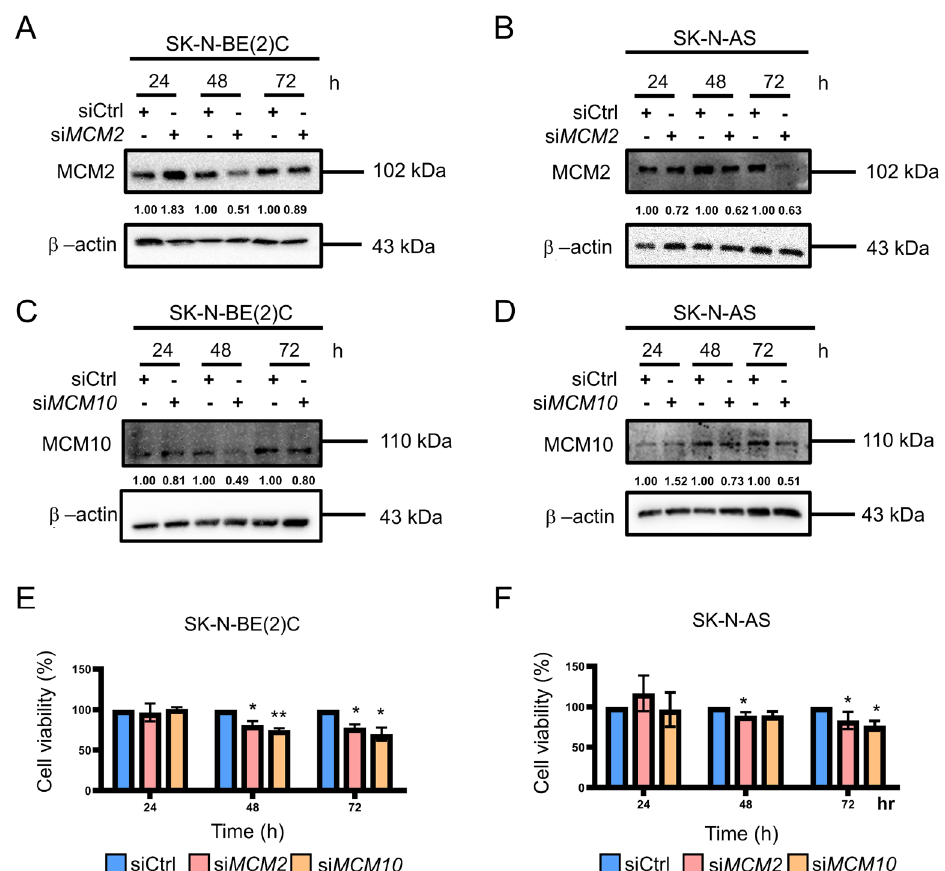
Figure 2. Knockdown of MCM2 and MCM10 reduced neuroblastoma cell proliferation: ( A – D ) Knockdown efficiency of MCM2 and MCM10 in SK-N-BE (2) C ( A , C ) and SK-N-AS ( B , D ) 24, 48, or 72 h post-transfection was confirmed with Western blot. ( E , F ) Cell viability in MCM2 or MCM10 silenced neuroblastoma cells. * p < 0.05, ** p < 0.01 from two-tailed unpair student t -test to determine whether the mean value of a given group is equal to the corresponding siCtrl group.